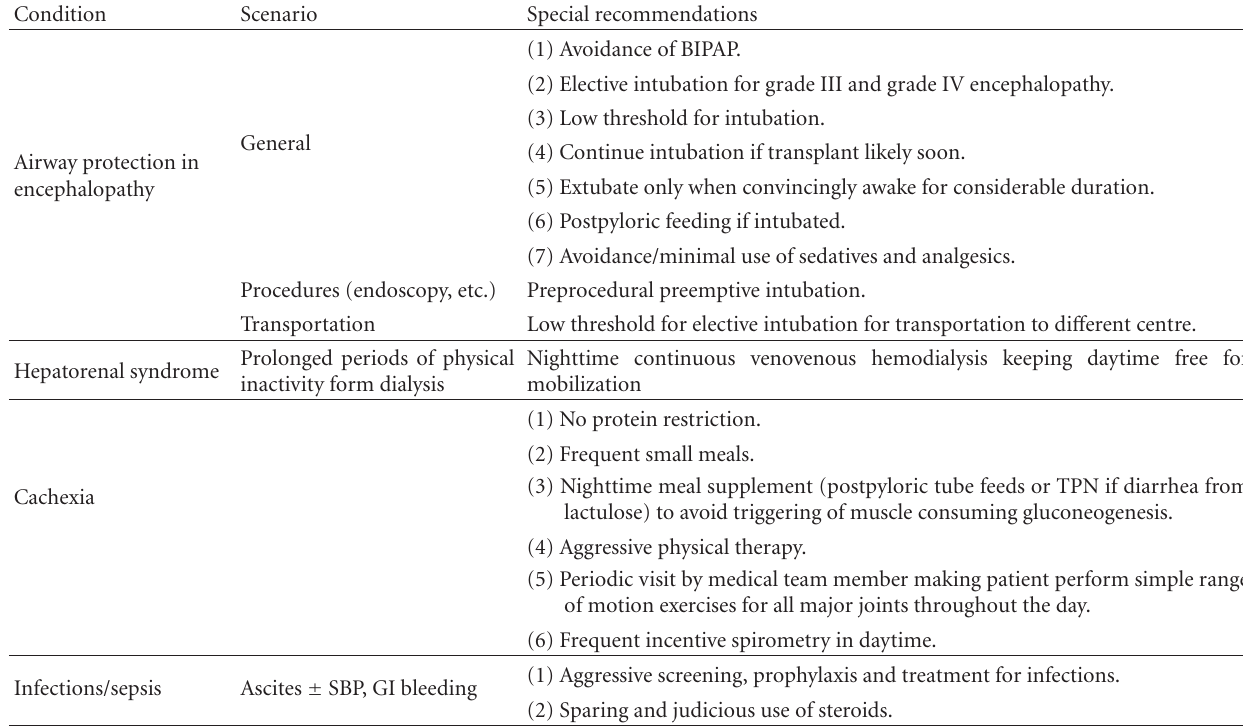
Table 2: High risk patient (high MELD Score > 30) and